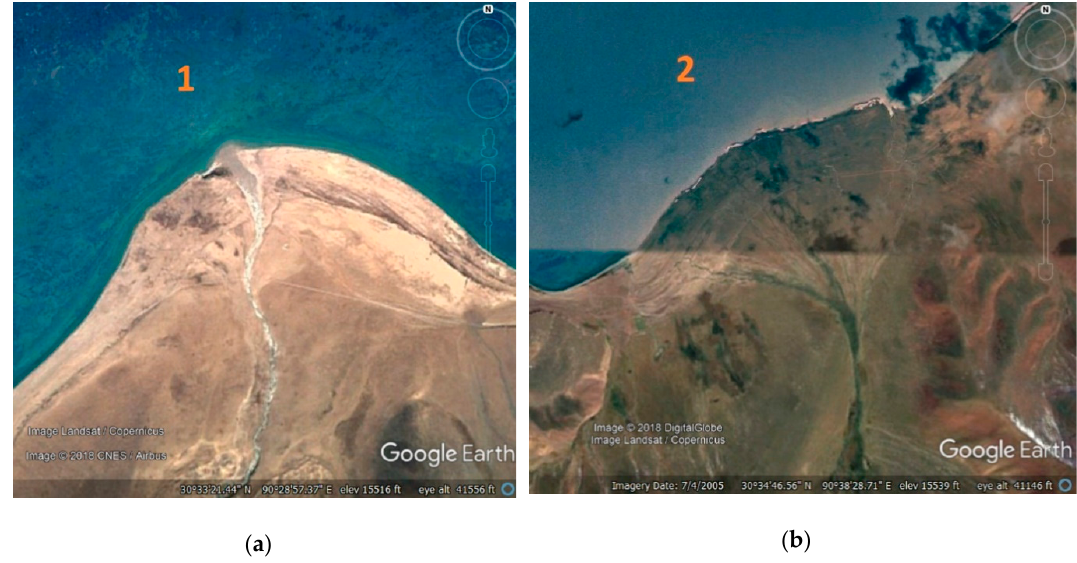
Figure 10. Google Earth imagery of each respective outlet from Figure 9, showing alluvial fans and potential multiple stream paths [49].